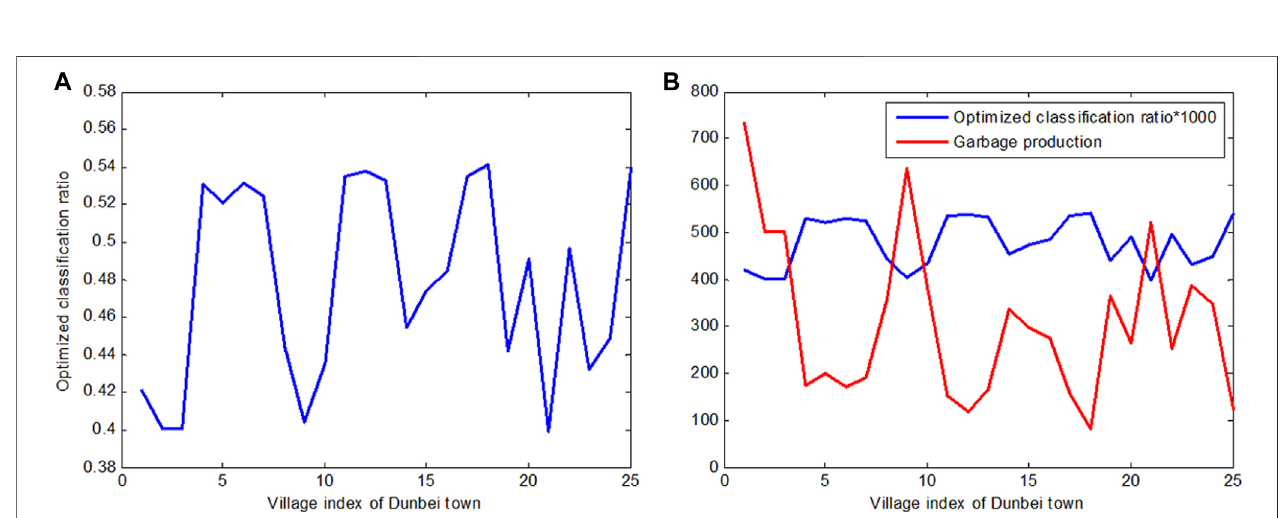
FIGURE4| Comparisonofclassi fi cationratioandgarbageproductionfromthesamevillagesinDatuotown. (A) classi fi cationratio; (B) classi fi cationratio(multiplied by 1000) and garbage